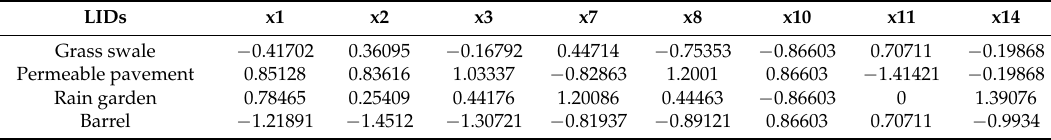
Table 11. Normalization of the eight selected variables of LCTIP by SPSS 22.0.